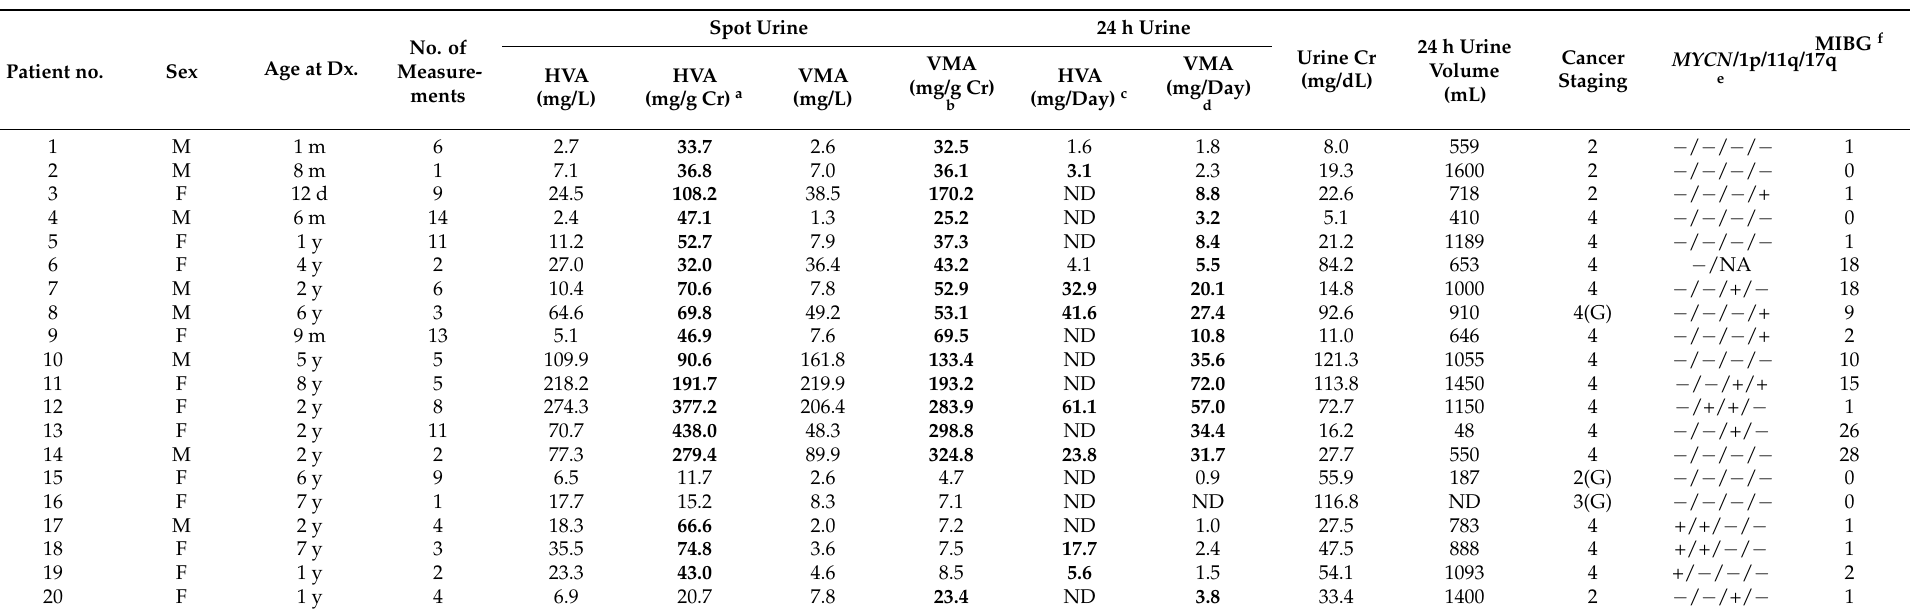
Table 3. Clinical characteristics and laboratory findings of 20 neuroblastoma patients at the onset of